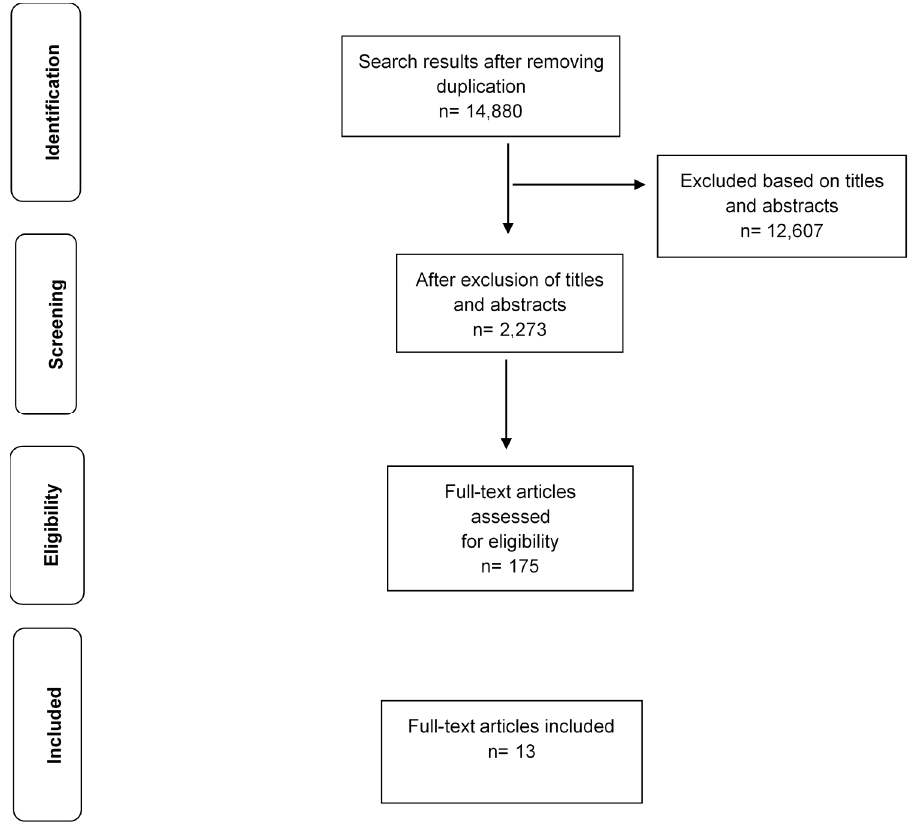
Figure 1. PRISMA flow diagram.